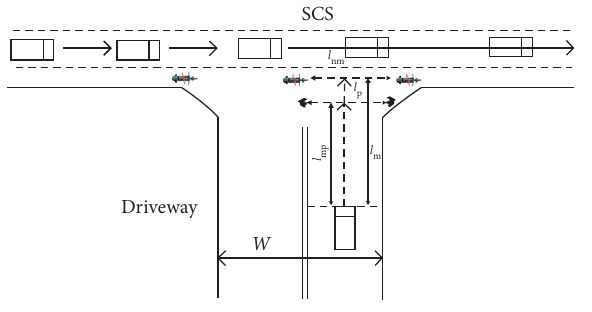
Figure 7: Crossing decision